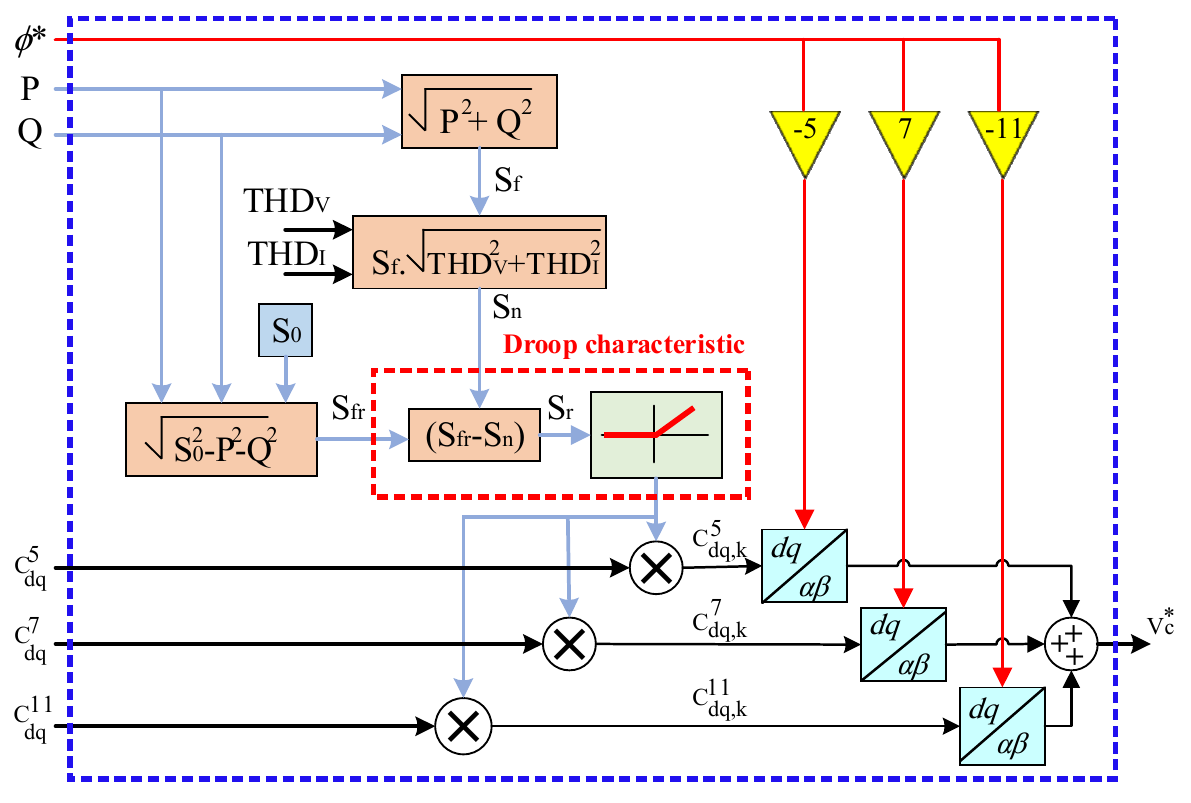
Figure 5. Compensator workload controller structure.